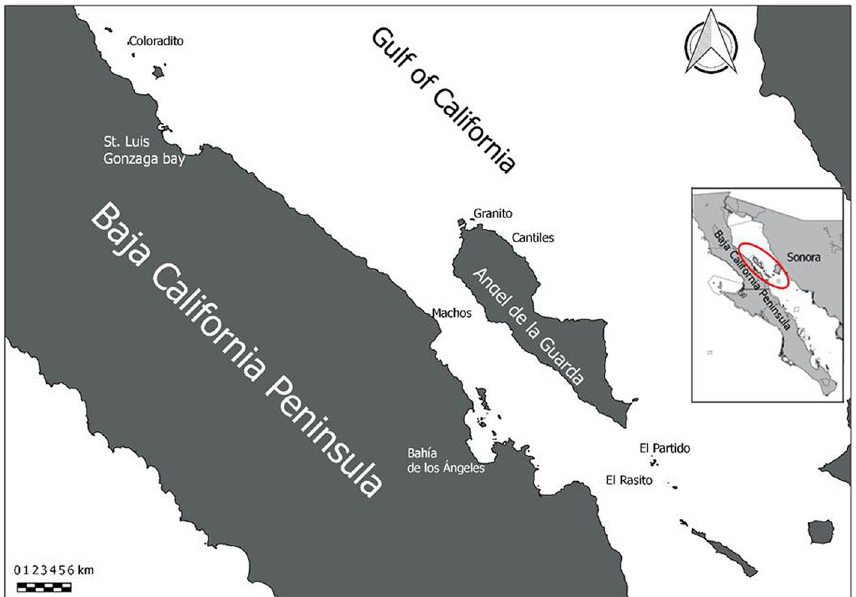
Figure 4. Islands Region in which the six sampled sea lion rookeries were located in the Gulf of California (GoC). The rookies included those of Coloradito, Granito, Cantiles, Machos, Partido, and